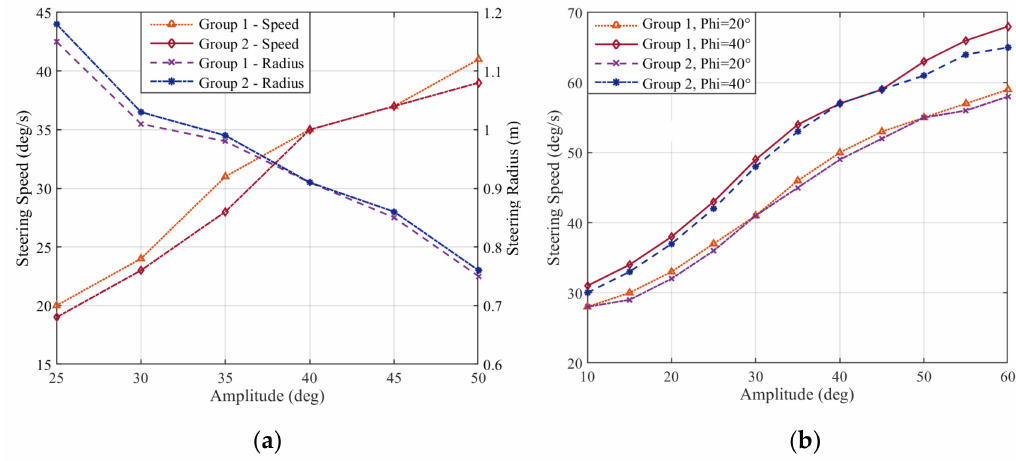
Figure 10. Maneuverability performance comparison of different fin groups. ( a ) Steering speed and radius in amplitude mode; ( b ) pivot steering speed in phase-difference